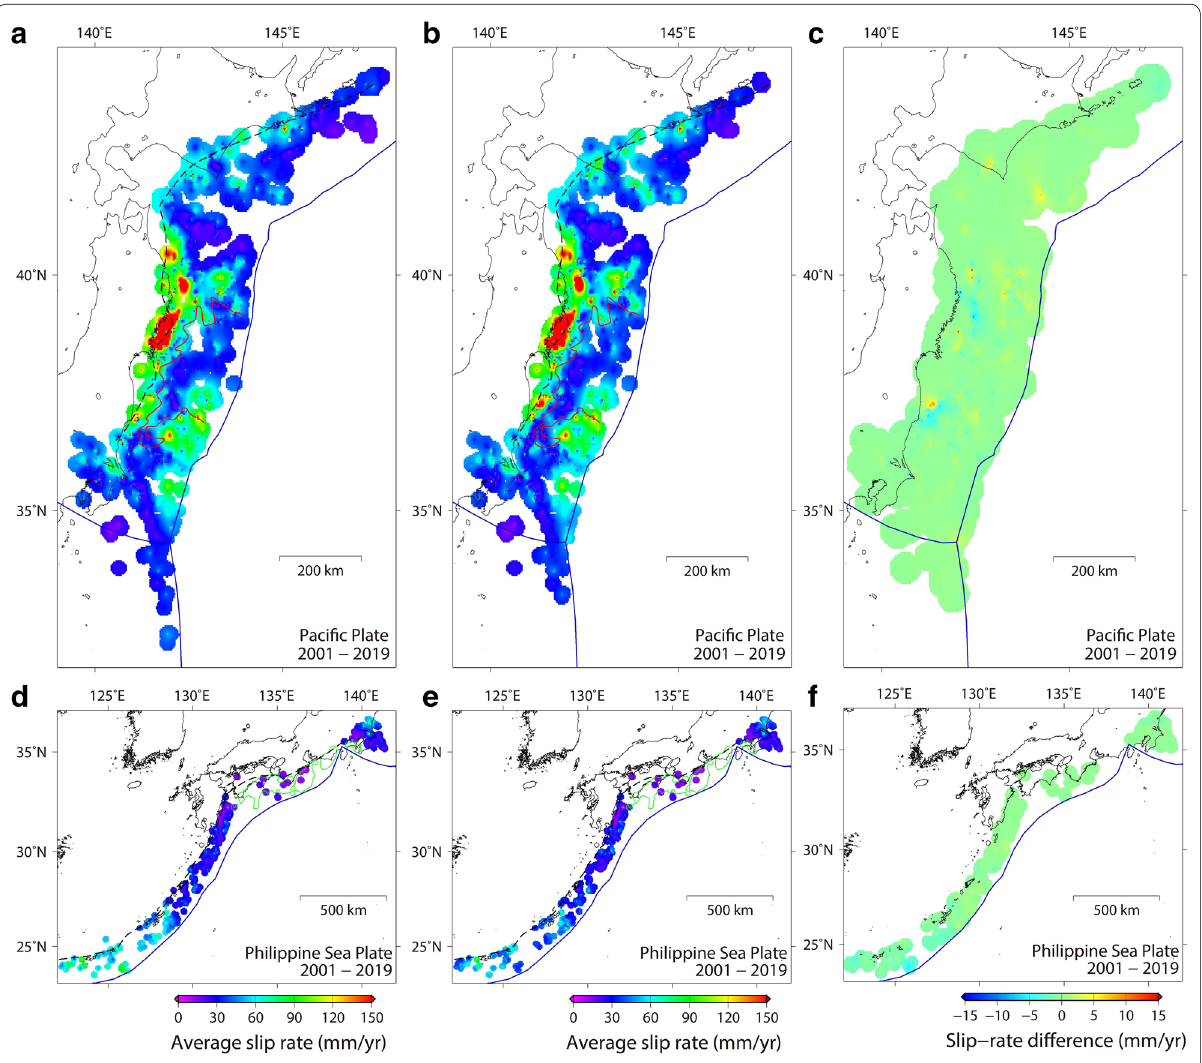
Fig. 4 Average slip rates estimated from similar and repeating earthquakes during the 2001–2019 period, and their differences. a , d Average slip rates estimated from similar earthquakes. b , e Average slip rates estimated from repeating earthquakes. c , f Slip rate differences. a – c are for the subducting Pacific Plate, and d – f are for the subducting Philippine Sea Plate. Dashed lines indicate the downdip limit of interplate coupling (Igarashi et al. 2001). Blue lines indicate plate boundaries. Red line in a and b denotes the outer edge of the large slip zone during the 2011 Tohoku-Oki Earthquake rupture (Kato and Igarashi 2012). Green lines in d and e indicate the asperities of large interplate earthquakes on the subducting Philippine Sea Plate (Baba and Cummins 2005; Sato et al. 2005) and the potential source region of the anticipated Tokai Earthquake (Central